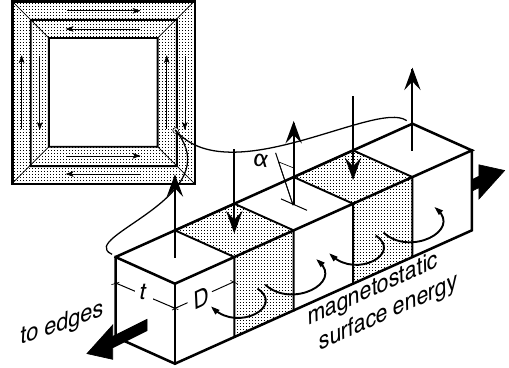
Figure 6. Detail of stripe domains in a demagnetized core. Thin ar- rows depict magnetic flux – the larger, vertical arrows indicating the dominant flux internal to the core, and the looped arrows depicting the smaller but significant flux crossing the free surface.